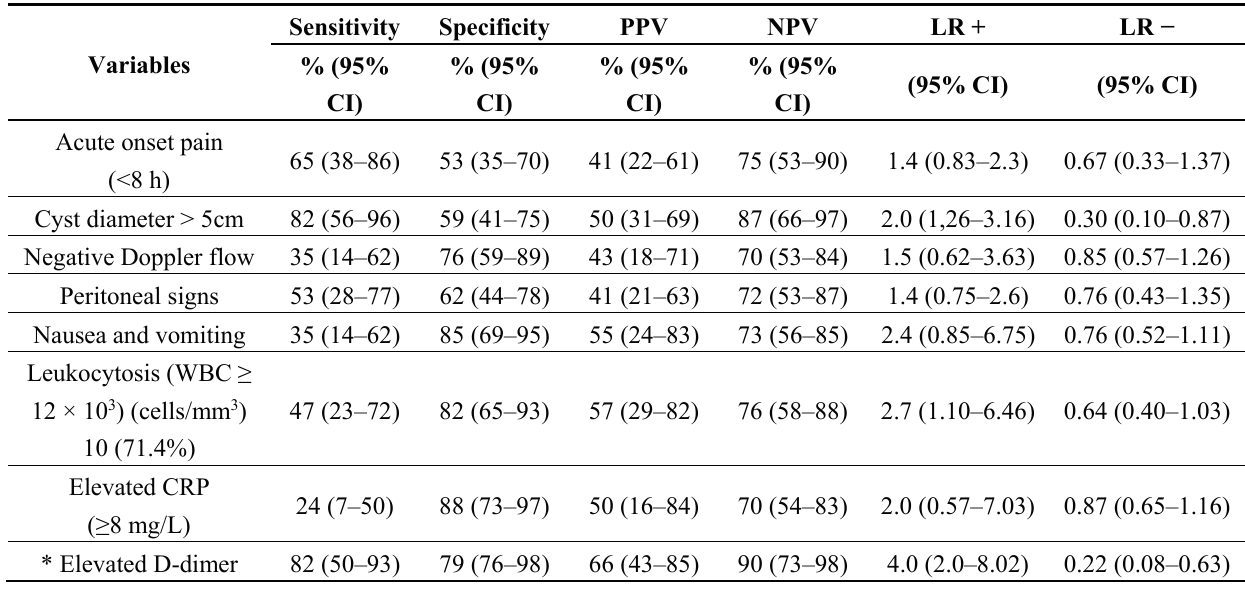
Table 5. Comparison of clinical features in pregnant patients with adnexal